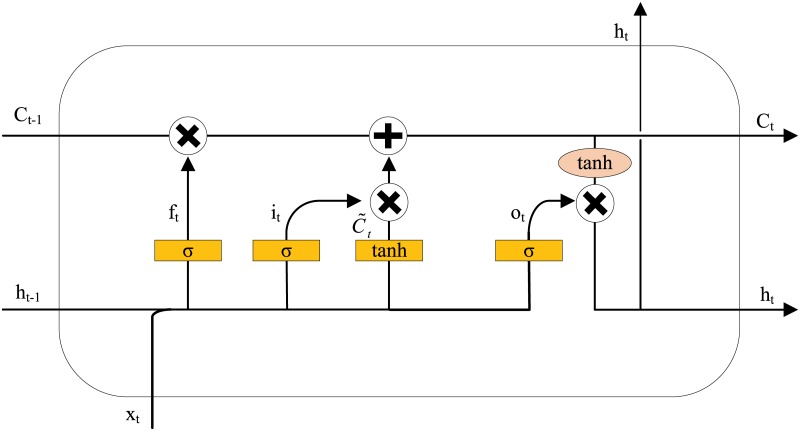
LSTM memory block.